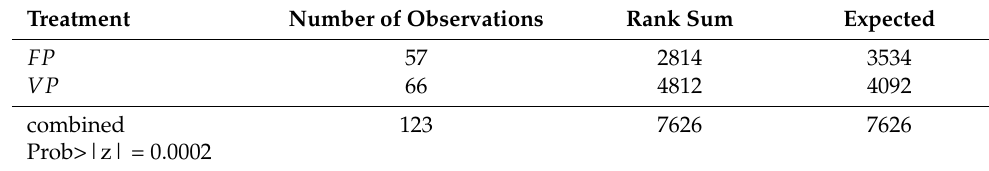
Figure 4. Distribution functions of helping behavior in FP vs. VP. Table 5. Mann—Whitney U ‐ Test.